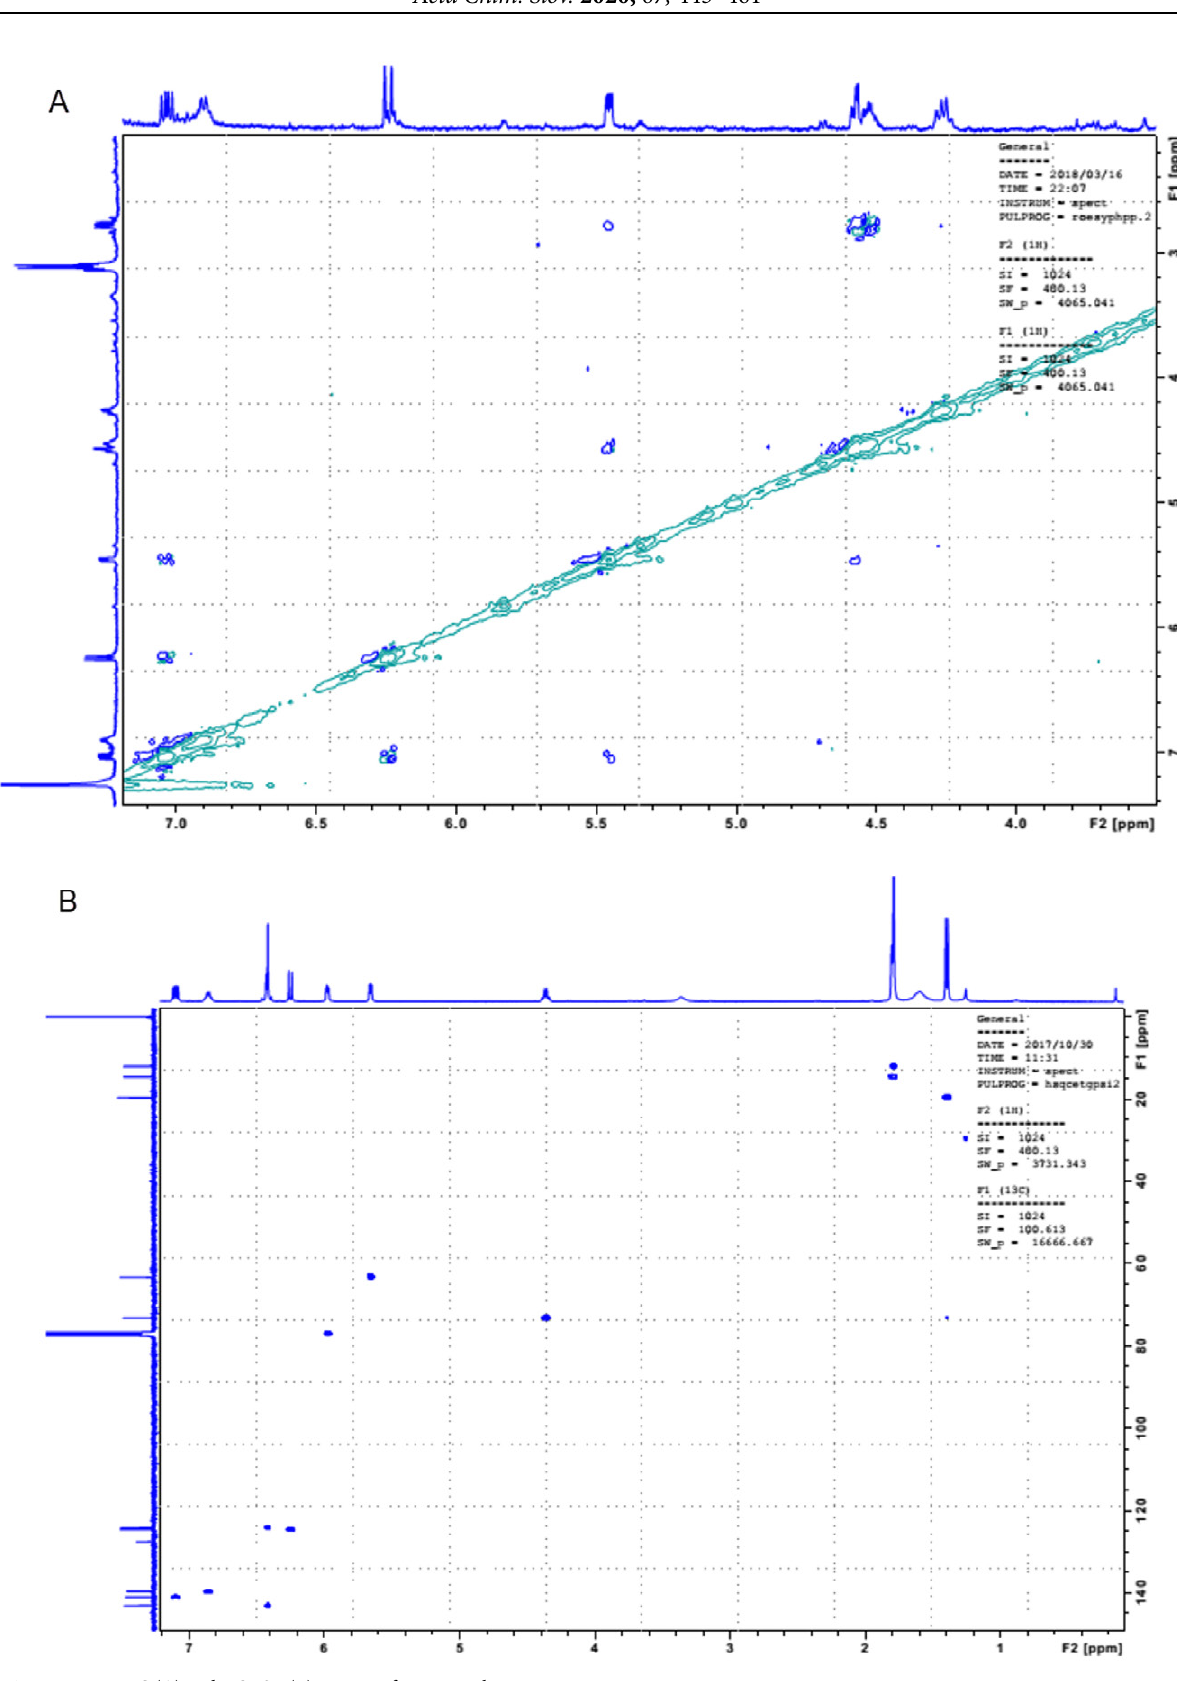
Figure 11. HMBC (A) and NOESY (B) spectra of compound